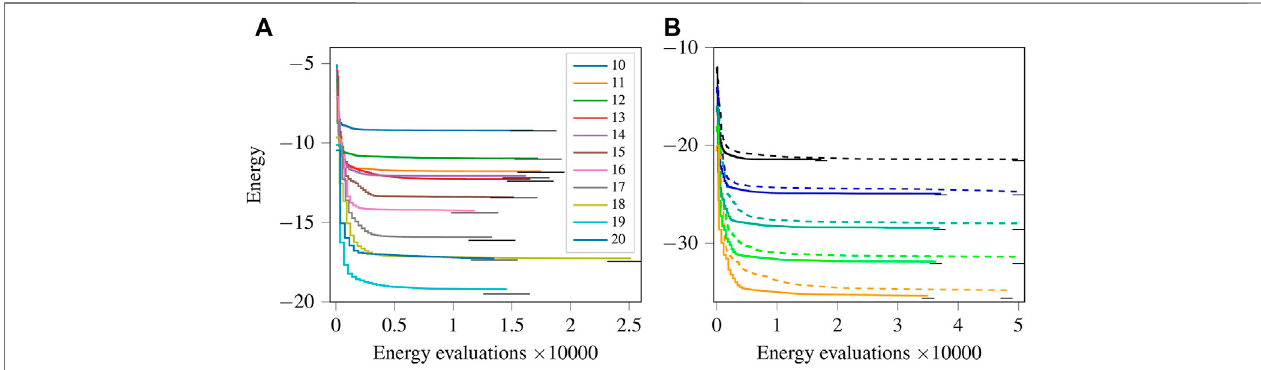
FIGURE 6 | (Colour online) (A) : Energy optimization progress using the XY-ansatz for different Hamiltonians with random coupling interactions for the different numbersofspinsshowninlegend. (B) :Energyoptimizationprogressusinggradient-based(solidlines)andgradient-free(dashedlines)optimizersforringswithisotropic couplings between the spins with 12 spins ( fi rst pair of the lines from top), 14 spins (second pair of lines from the top), and so on up to 20 spins (last pair of lines at the bottom). The short horizontal black lines represent the ground state energy.